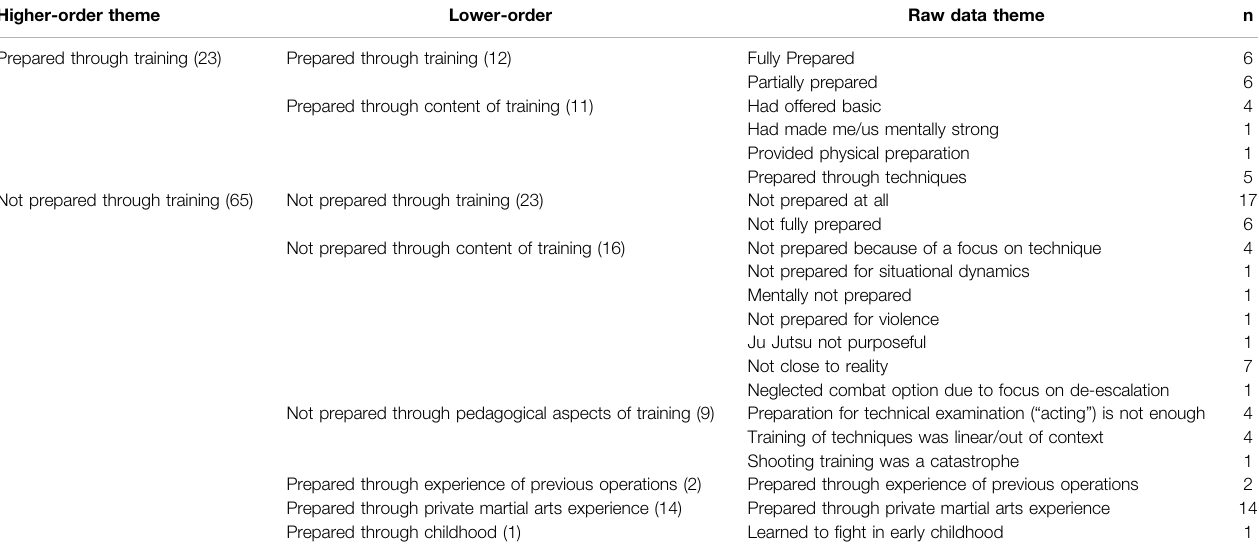
TABLE 3 | Results of qualitative analysis whether training prepared for experienced con fl icts (Numbers in column after raw-data theme denote number of participants contributing to the raw-data theme; numbers in brackets denote total number of meaning units for lower-order and higher-order theme). Higher-order